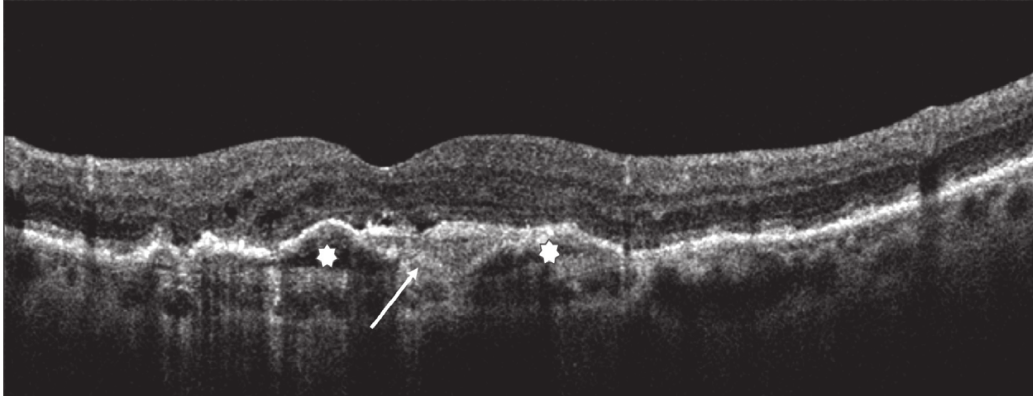
Figure 5: Structural OCT biomarkers: subretinal hyperreflective material (SRHM; white arrow) and pigment epithelium detachment (white